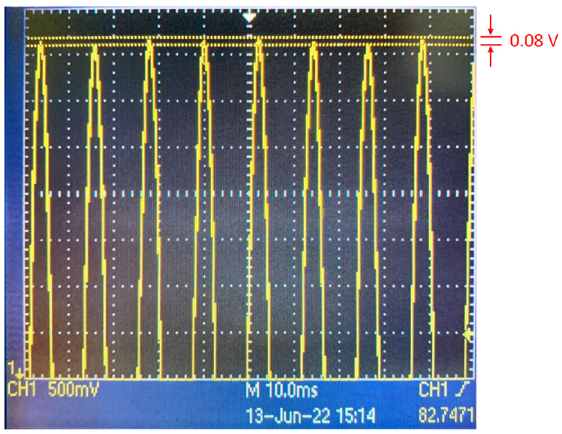
Figure 9. PSD output of the scanner angular repeatability test. The output voltage amplitude is ~5 V with variation of <0.08 V, i.e., ~1.6%.